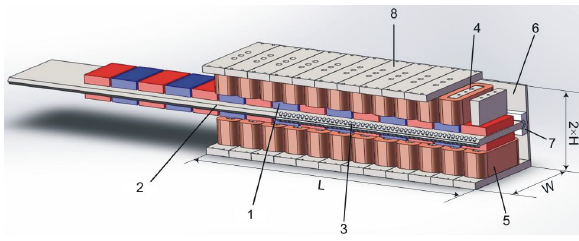
Figure 2: A conceptual configuration of the electromagnetic actuator proposed